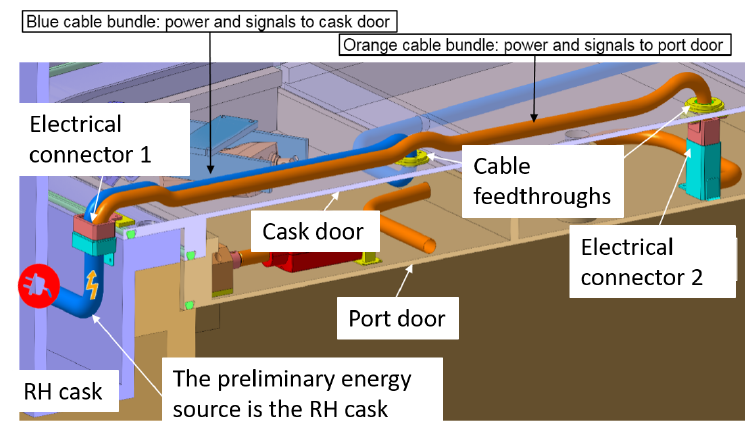
Figure 9. The electrical connectors in the